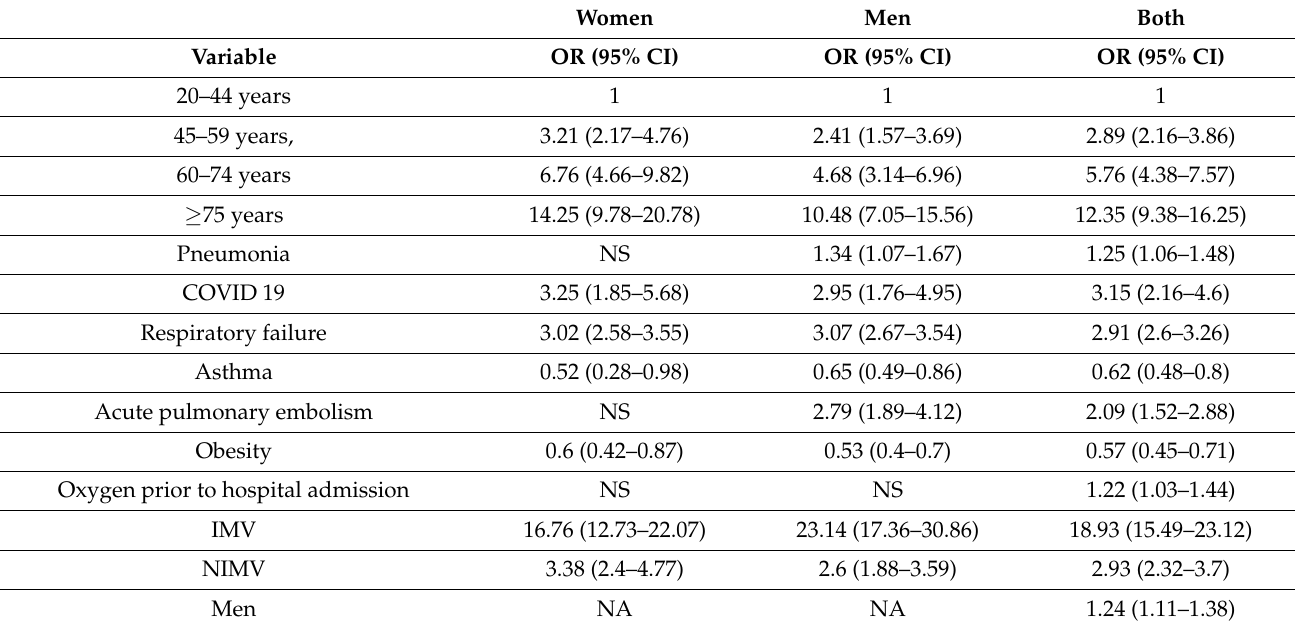
Table 5. Logistic regression to assess variables associated with IHM among women and men hospi- talized with sarcoidosis in Spain from 2001 to 2020, according to